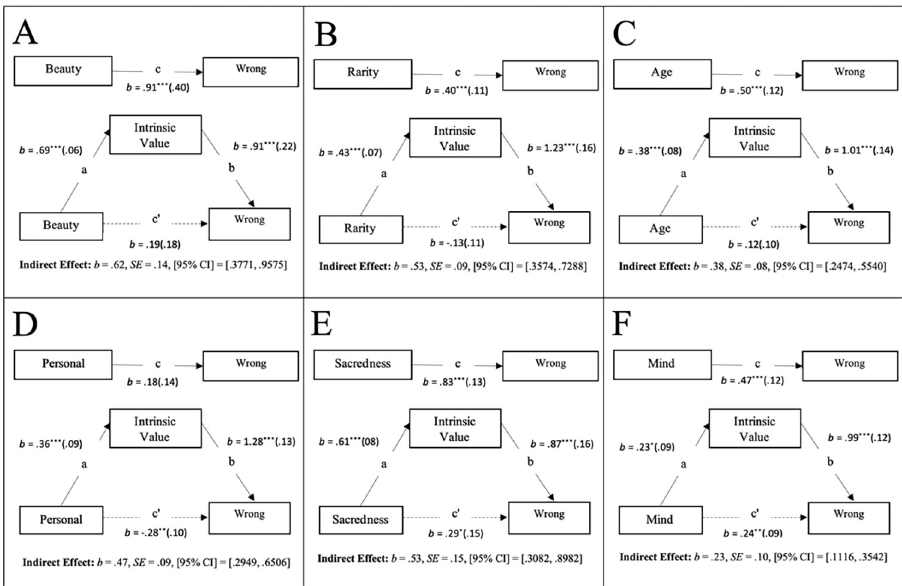
Fig 2. Mediation models for wrongness to destroys Study 4. Notes: Unstandardized coefficients and standard errors (in Study 4) for effects of Beauty (Panel A), Rarity (Panel B), Age (Panel C), Personal (Panel D), Sacredness (Panel E) and Mind Possession (Panel F), on “How wrong would it be to destroy ... ”, via the Mediator of Intrinsic Value. In each panel, the top model represents the total effect, and the bottom model represents the direct/indirect effects.